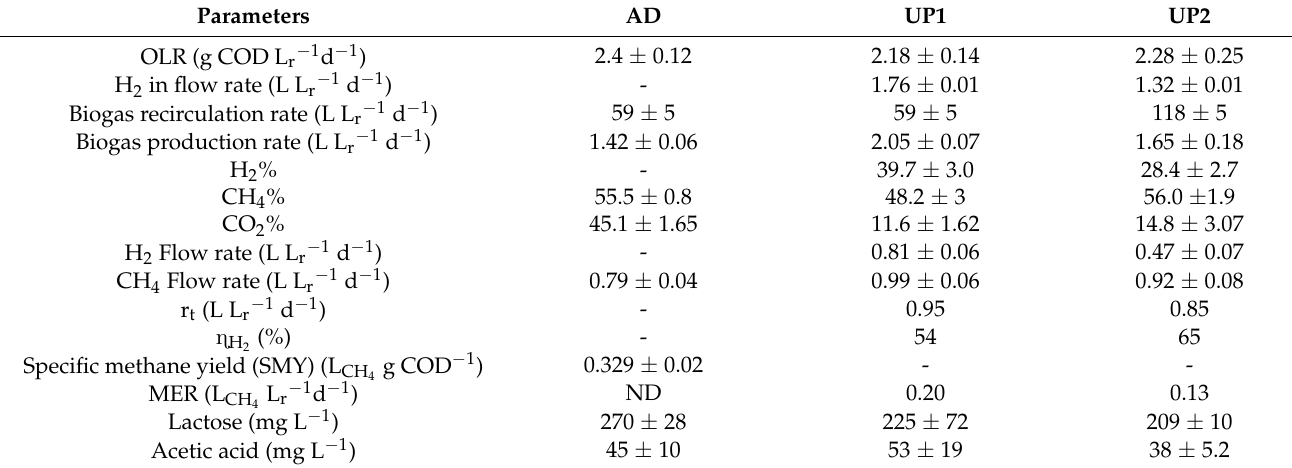
Figure 2. Daily course profiles of process performances during the three experimental phases. Table 2. Process performances at the end of the three experimental phases.